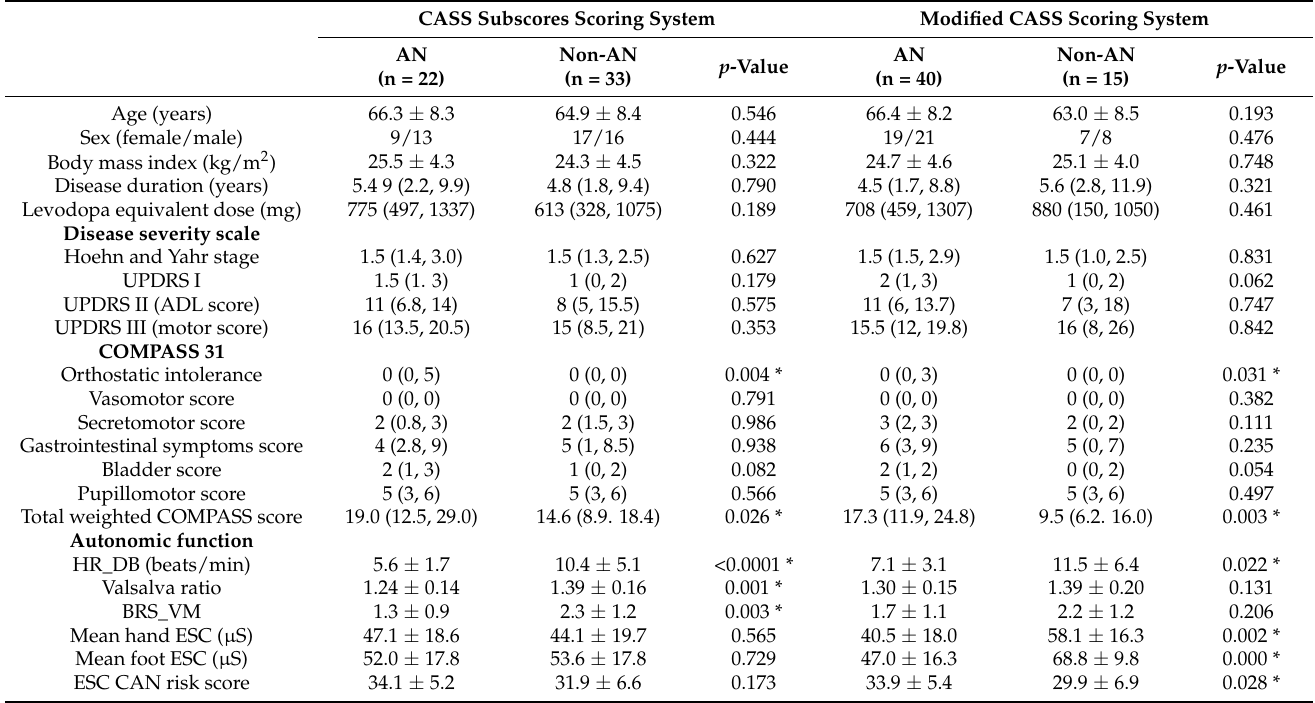
Table 4. Comparison of baseline characteristics and parameters of autonomic function between AN and non-AN groups according to CASS subscores and modified CASS scoring system.